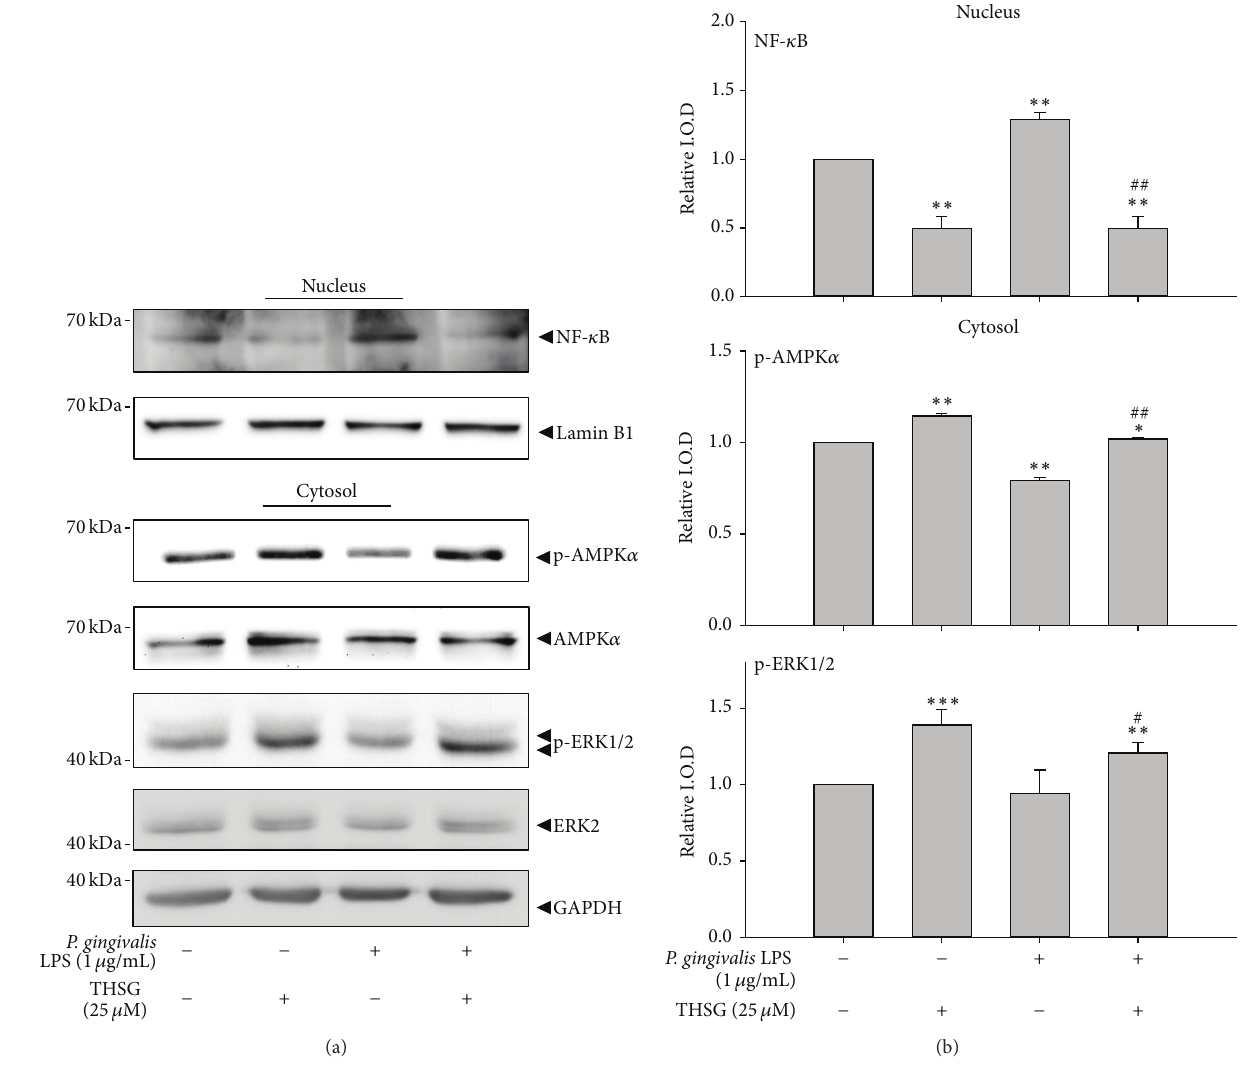
Figure 4: THSG attenuated P. gingivalis LPS-induced proinflammatory cytokines expression via reducing NF- 𝜅 B activation and activating AMPK and ERK1/2 in HGFs. HGFs were cultured in 10-cm dishes and starved for 24h when the cell confluence reached 80%. HGFs were pretreated with 100 𝜇 M resveratrol and THSG for 30 min and then treated with 1 𝜇 g/mL P. gingivalis LPS for another 3 h. (a) The cytosolic and nuclear proteins of HGFs were extracted and Western blot was performed. (b) The relative intensity of nuclear translocation of NF- 𝜅 B and activation of AMPK and ERK1/2 were evaluated. ( 𝑁 = 3 ; ∗ 𝑝 < 0.05 ; ∗∗ 𝑝 < 0.01 ; ∗∗∗ 𝑝 < 0.001 were compared with control group. # 𝑝 < 0.05 ; ## 𝑝 < 0.01 were compared with LPS